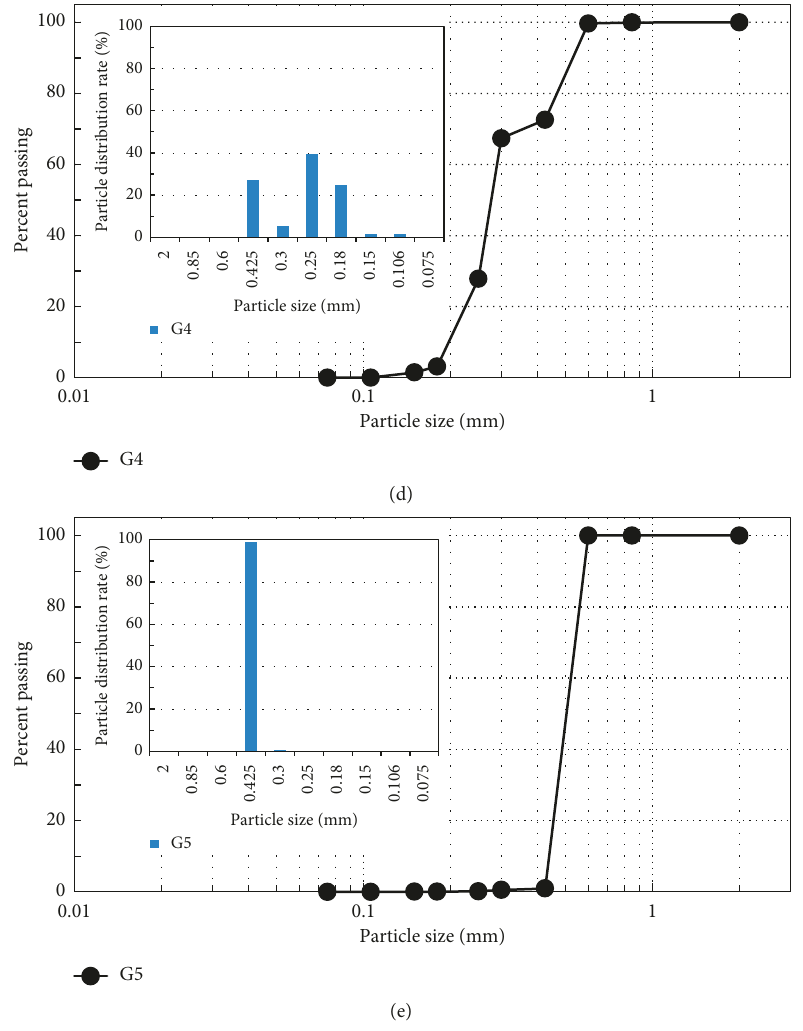
Figure 4: Particle size distributions according to the garnet type.